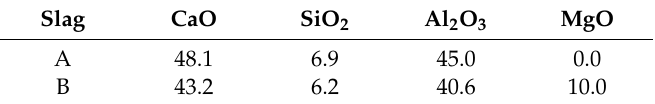
Table 3. Initial component of slag before experiments (wt.